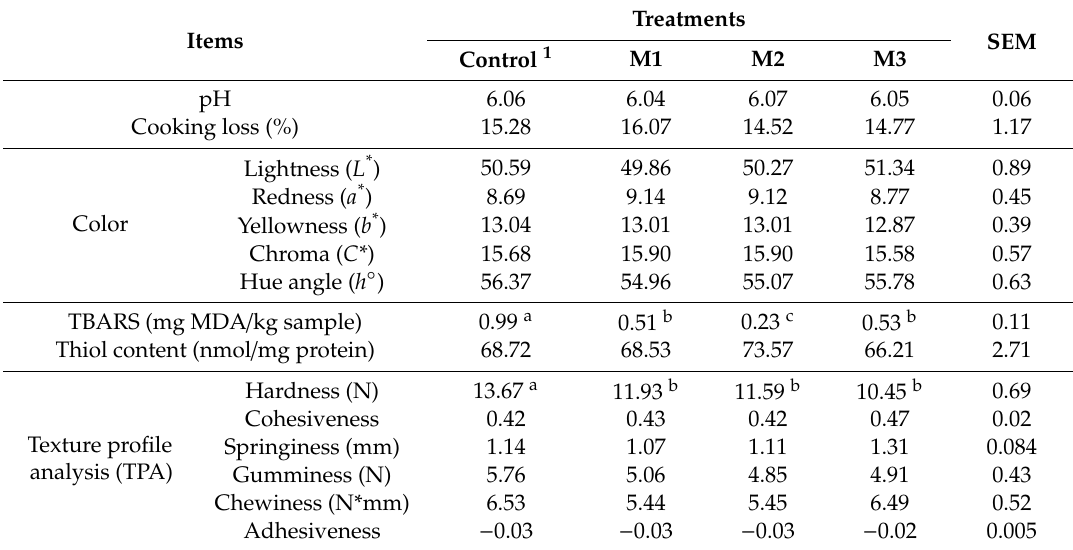
Table 2. E ff ect of precooking (convection oven) on physicochemical characteristics of nutmeg extract enriched beef